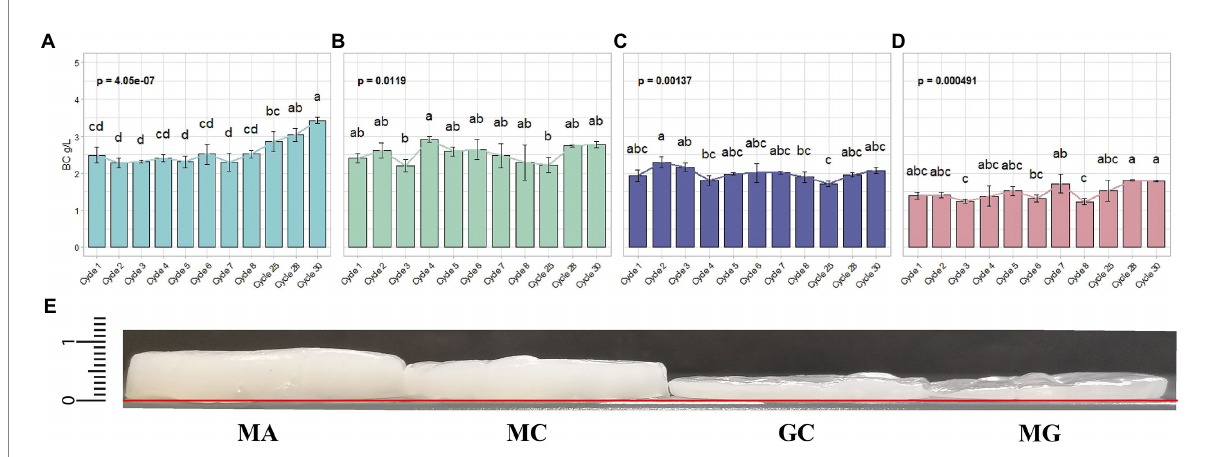
FIGURE 2 Quantification of BC yield in the four conditions tested (A) MA (B) MC (C) GC (D) MG. Each bar indicating the mean ± SD of BC yield in the representative cycles. Significant difference among the BC yield was represented by letters. (E) Layers thickness of native BC pellicles at cycle 30: MA = 0.85 mm; MC = 0.70; GC = 0.40; MG = 0.40. The baseline was marked in